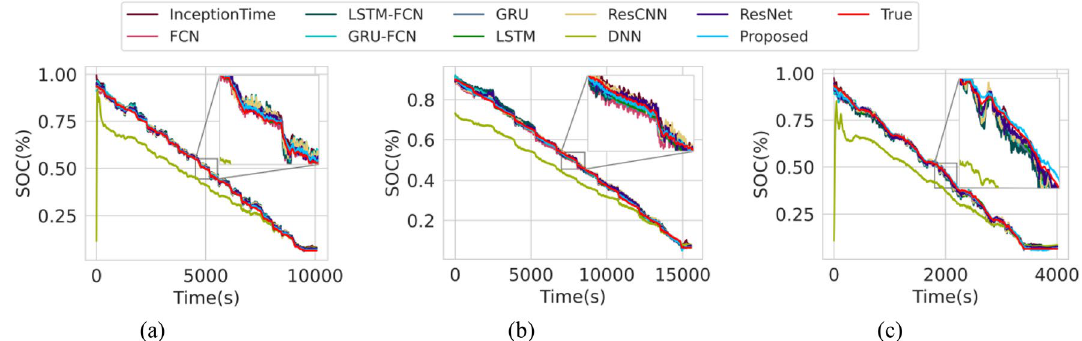
Figure 1. SOC estimation at room temperature. ( a ) LA92 drive cycle at 25 °C. ( b ) UDDS drive cycle at 25 °C. ( c ) US06 drive cycle at 25 °C.